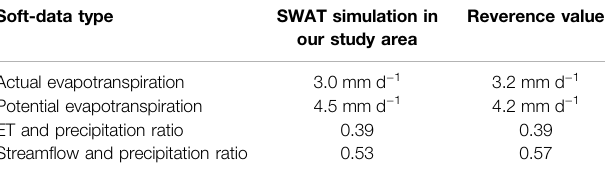
TABLE 5 | Calibration and validation of SWAT simulation using soft